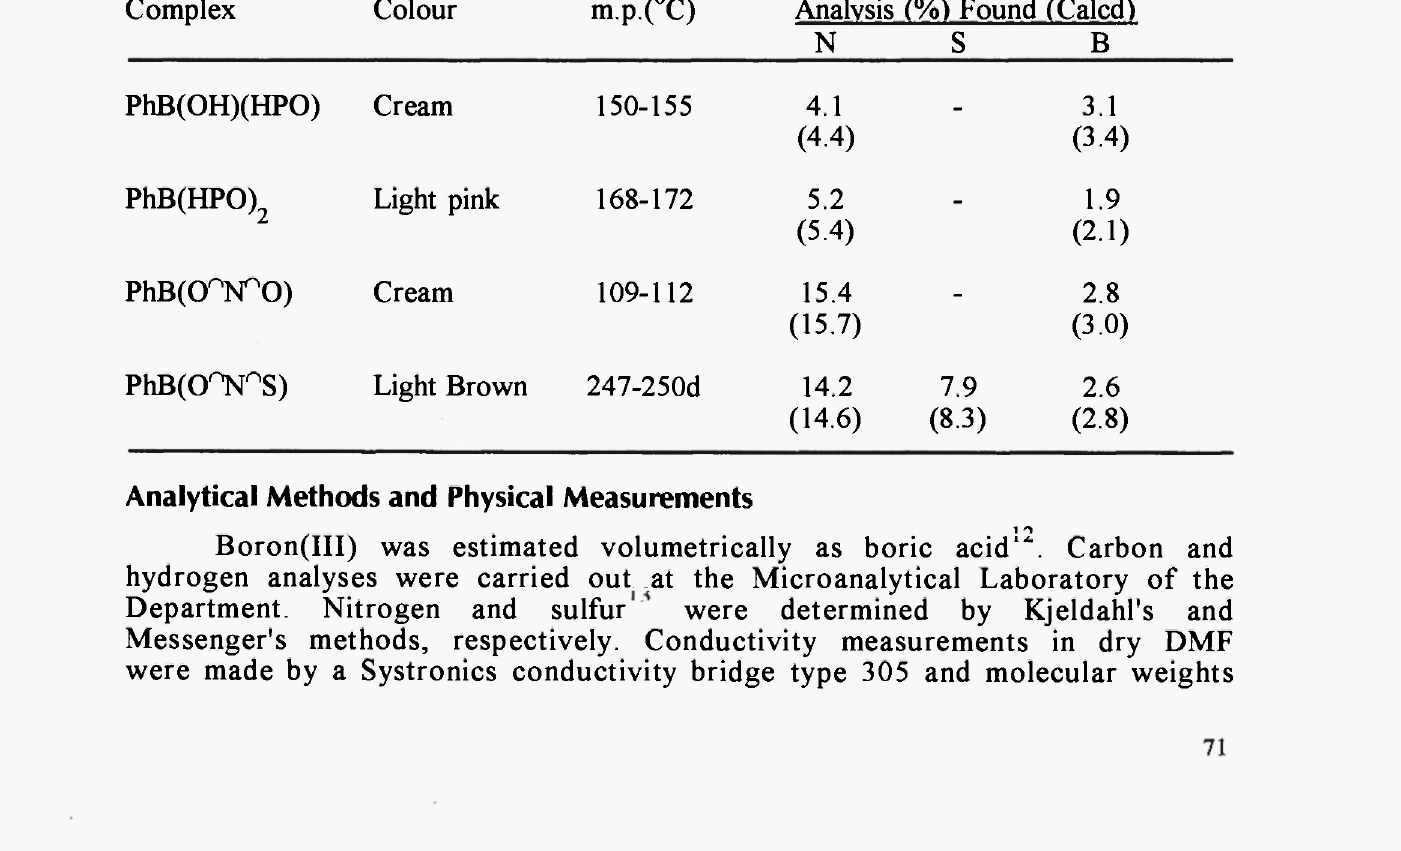
Table II - Physical Properties and Analytical Data of the Complexes